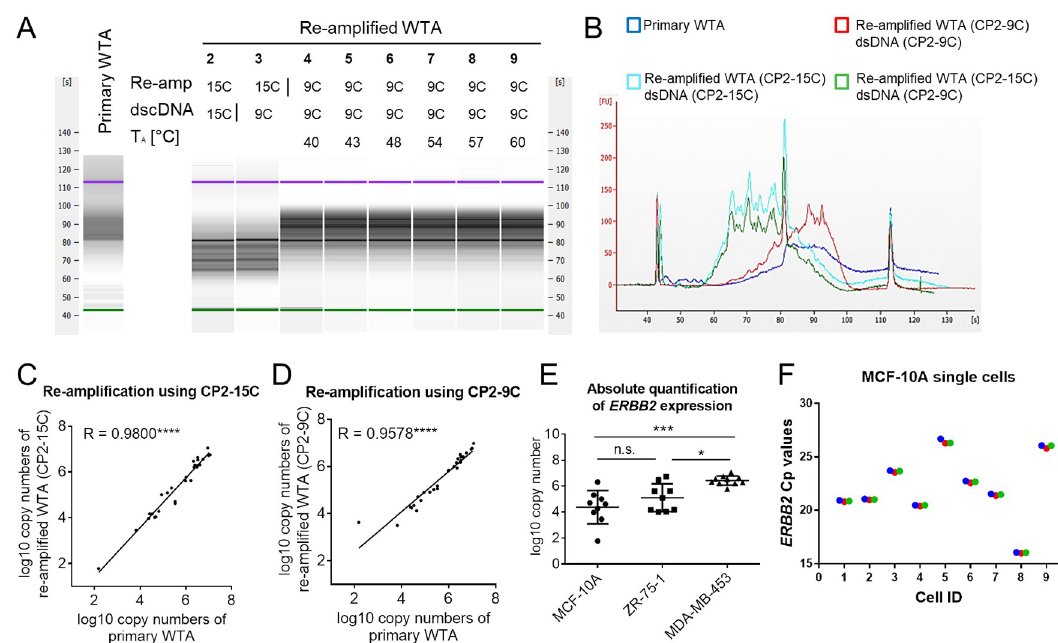
Fig 4. Single-cell qPCR analysis utilizing re-amplified WTA products. (A,B) Fragment size distribution of primary WTA and corresponding WTA re-amplification products (generated with either the CP2-15C or the CP2-9C primer) of one representative BT-474 single cell assessed by Bioanalyzer assay. (A) 2–9: Re-amplified WTA products generated using the indicated primer sequence for re-amplification and dscDNA-synthesis. 4–9: Samples re-amplified with different annealing temperatures (T A ). (B) Electropherogram of selected samples. (C,D) Correlation between qPCR results conducted with primary and re-amplified WTA using CP2-15C (C) and CP2-9C (D) primers for re-amplification. (E) Absolute quantification of ERBB2 transcript levels in MCF- 10A, ZR-75-1 and MDA-MB-453 cells using re-amplified single-cell WTA products (generated using the CP2-9C primer). (F) Cp values of ERBB2 expression generated for MCF-10A single cells after re-amplification using CP2-9C primer. Red, green and blue represent three different